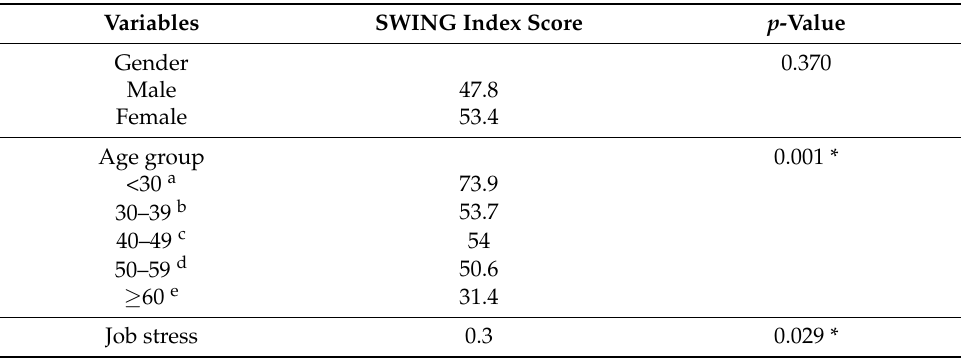
Table 3. Associations of SWING index score with variables.